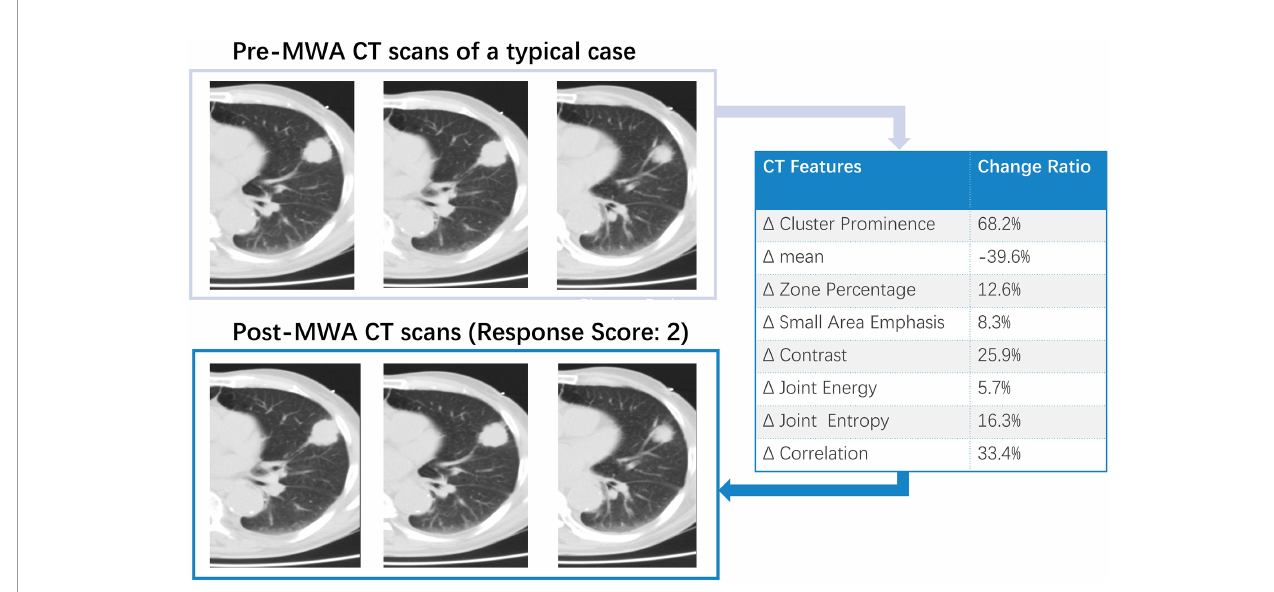
FIGURE 2 | A typical example of intra-tumoral tissue density features ’ change in CT image for patient with incomplete ablation.